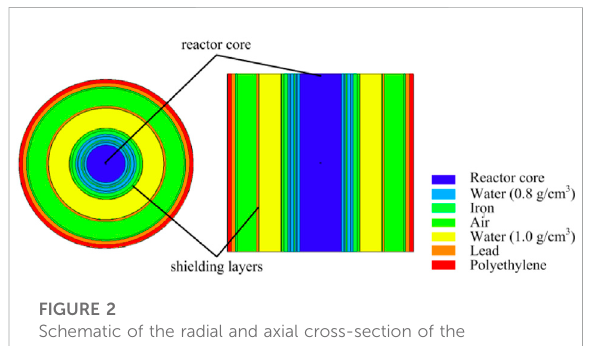
FIGURE 2 Schematic of the radial and axial cross-section of the simpli fi ed Savannah reactor shield model.